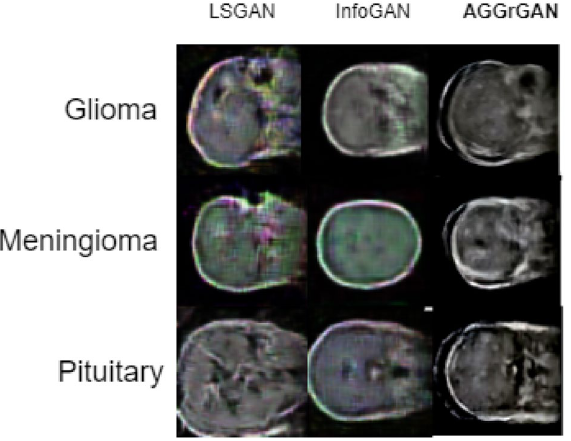
Figure 5. Visual comparison between samples images generated by existing GAN architectures like LSGAN, InfoGAN and the proposed AGGrGAN in brain tumor dataset 34 where each row represents images of the same class and each column represents images generated by the same method.